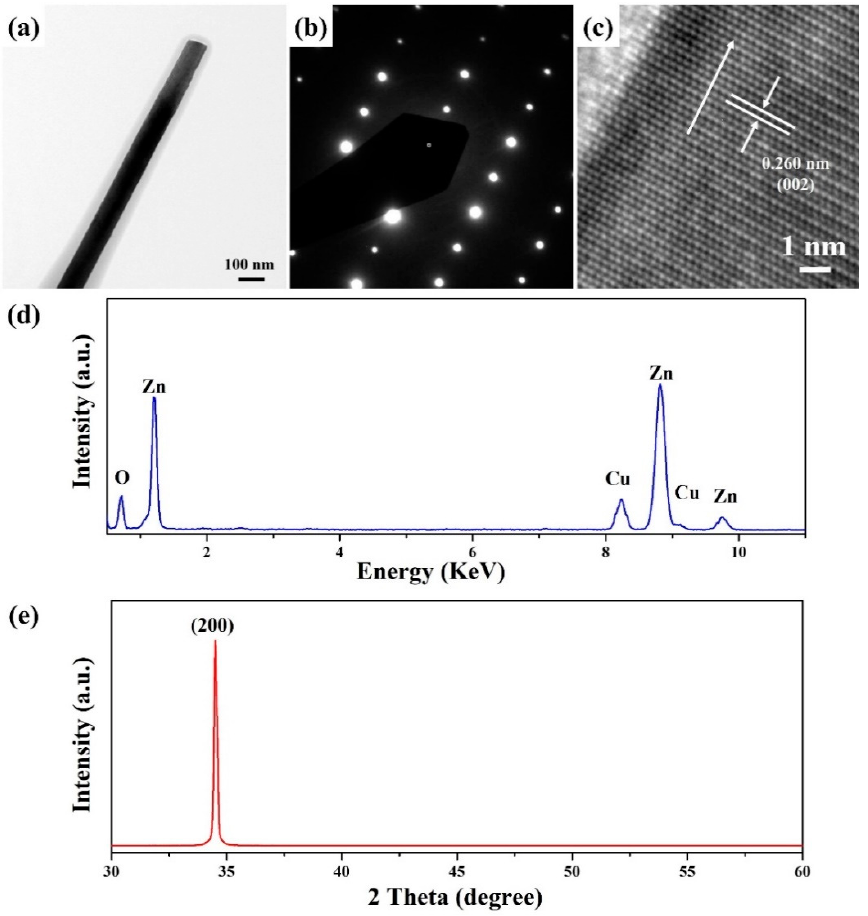
Figure 3. ( a ) FETEM, ( b ) SAED pattern, ( c ) HRTEM images, and ( d ) EDS spectrum of a ZnO nanowire (50 mM). ( e ) The XRD diffraction pattern of ZnO nanowires (50 mM) synthesized on the glass substrate with a ZnO seed film.